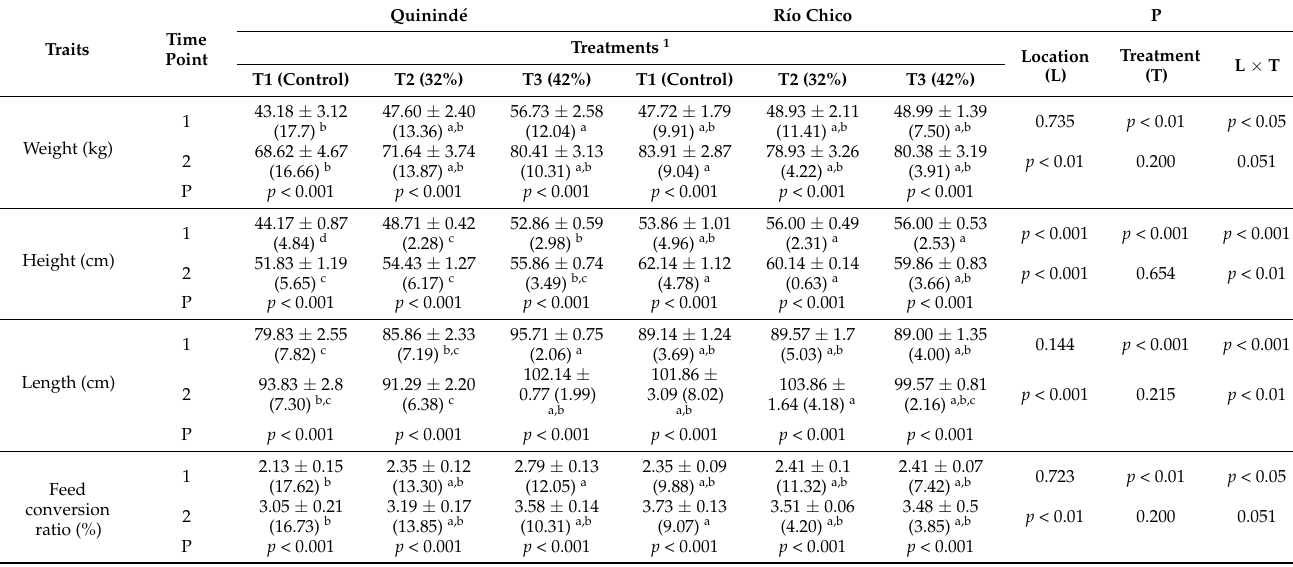
Table 5. Productive performance (mean ± standard error (coefficient of variation)) of backyard pigs fed in fattening stage with different formulations of cassava and taro in two locations in Ecuador (Quinind é and R í o Chico).